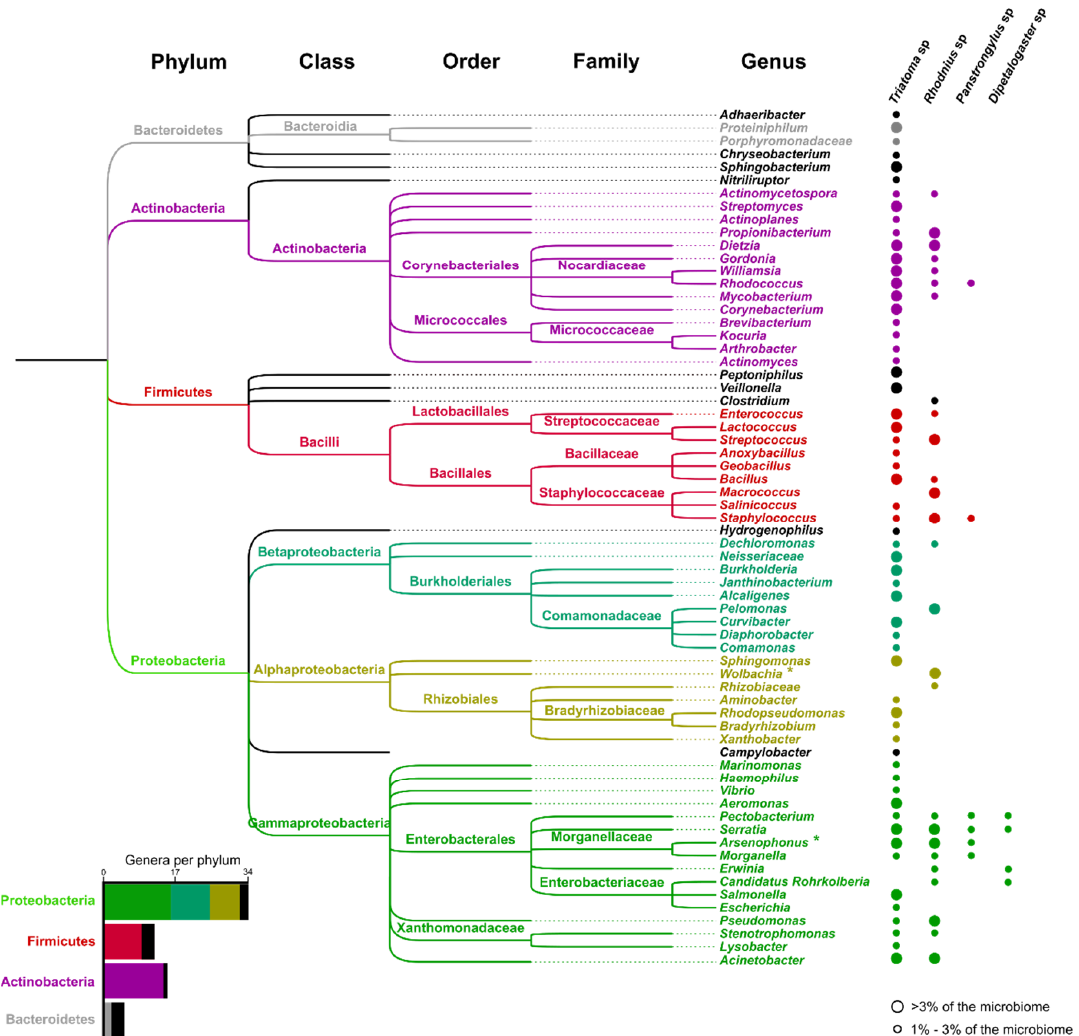
Figure 2. The predominant bacteria from the GI tract of triatomines. Bacteria that represent over 1% of microbiomes from triatomine GI tracts belong to the phylum Bacteroidetes (5 genera in the clade in grey), Actinobacteria (14 genera in the clade in purple), Firmicutes (12 genera in the clade in red), and Proteobacteria (33 genera in the clade in green). Bacteria classes with only 1 representative genus are colored in black. The presence of these bacteria in different triatomines is shown as circles on the right side. Dominant bacteria (1%–3% of a microbiome) are represented with small circles and highly dominant bacteria (>3% of a microbiome) are represented with larger circles. The family Nocardiaceae and the order Enterobacteriales have many highly abundant bacteria. Intracellular bacteria are marked with a *. Data to build this figure were taken from [9,74,233–243]. The phylogenetic tree depicting the evolutionary relationships among bacteria was modified after retrieval from the NCBI taxonomy